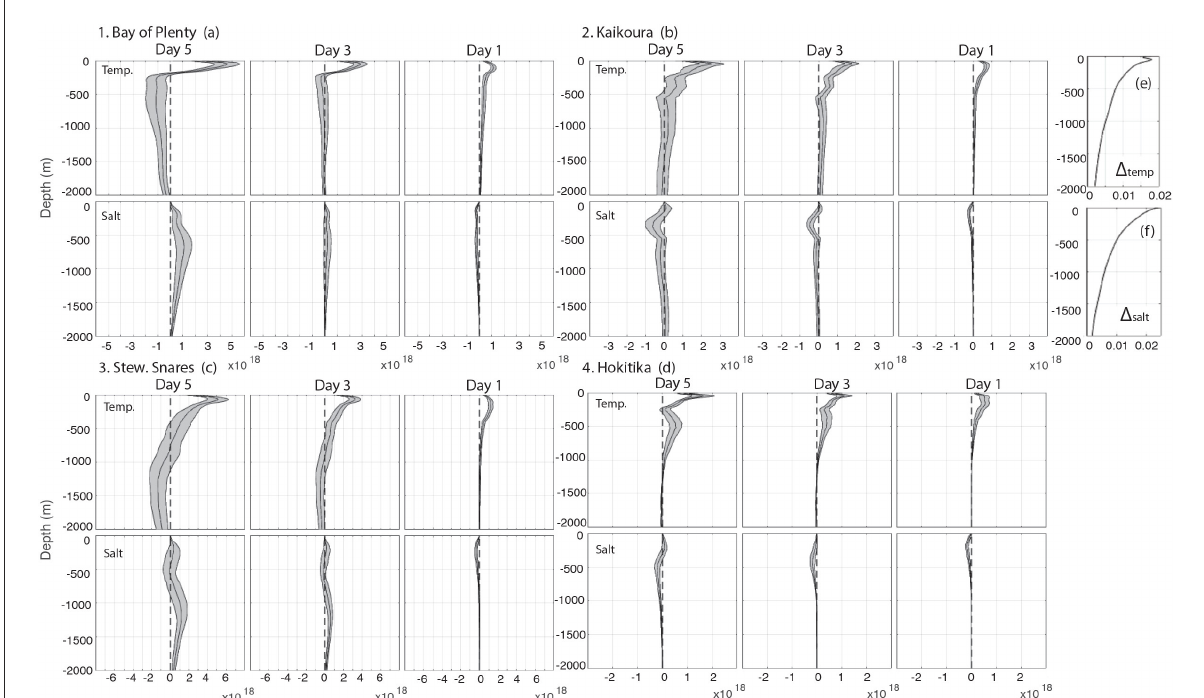
FIGURE5 Sensitivity to temperature and salinity outside of the region scaled by the 5-day standard deviations for all MHWs for days 5, 3 and 1 prior to the first day of the MHW event for regions 1. Bay of Plenty (a) , 2. Kaikoura (b) , 3. Stewart Plateau and Snares Shelf (c) , and 4. Hokitika (d) . The perturbations used for scaling the sensitivities are shown in (e) for temperature and (f) for